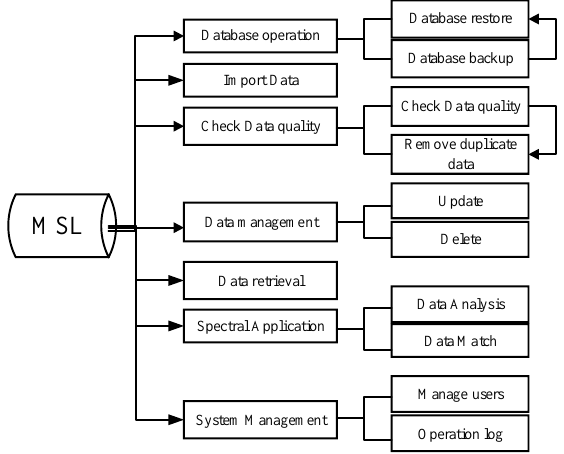
Figure 2. Main function of